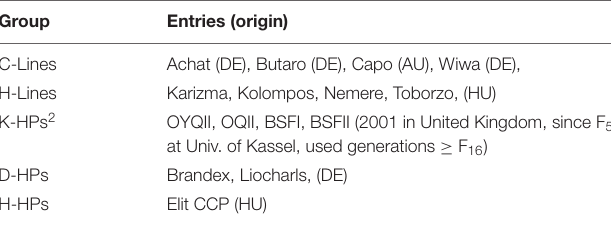
TABLE 1 | Wheat entries used, grouped by type (HP, heterogeneous population; Line, line cultivar) and origin (C, central Europe; H, Hungary, K, Kassel University; D, Dottenfelder